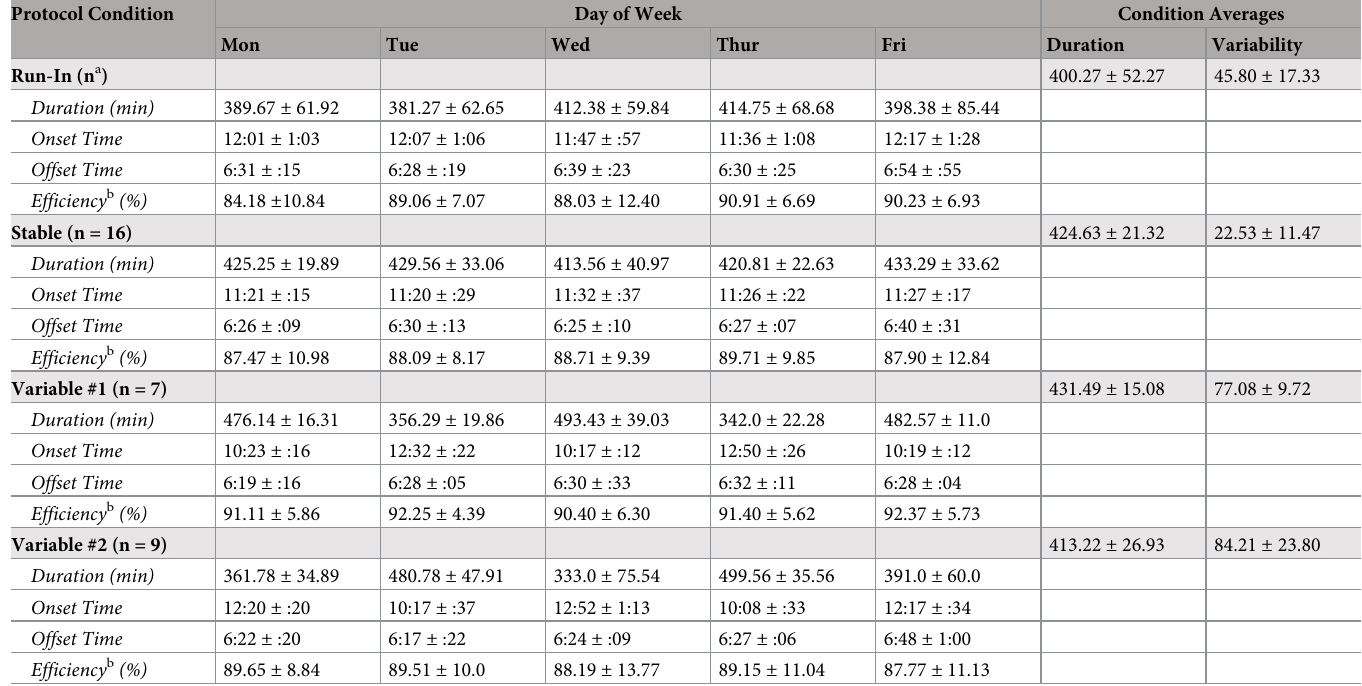
Table 3. Daily-level actigraph parameters across the stable sleep condition and each variable sleep condition for adherent participants. Protocol Condition